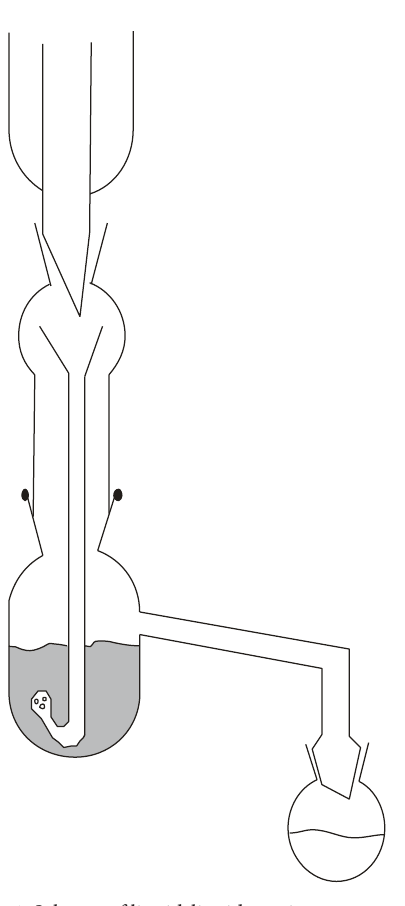
Figure 1: Scheme of liquid-liquid continuous